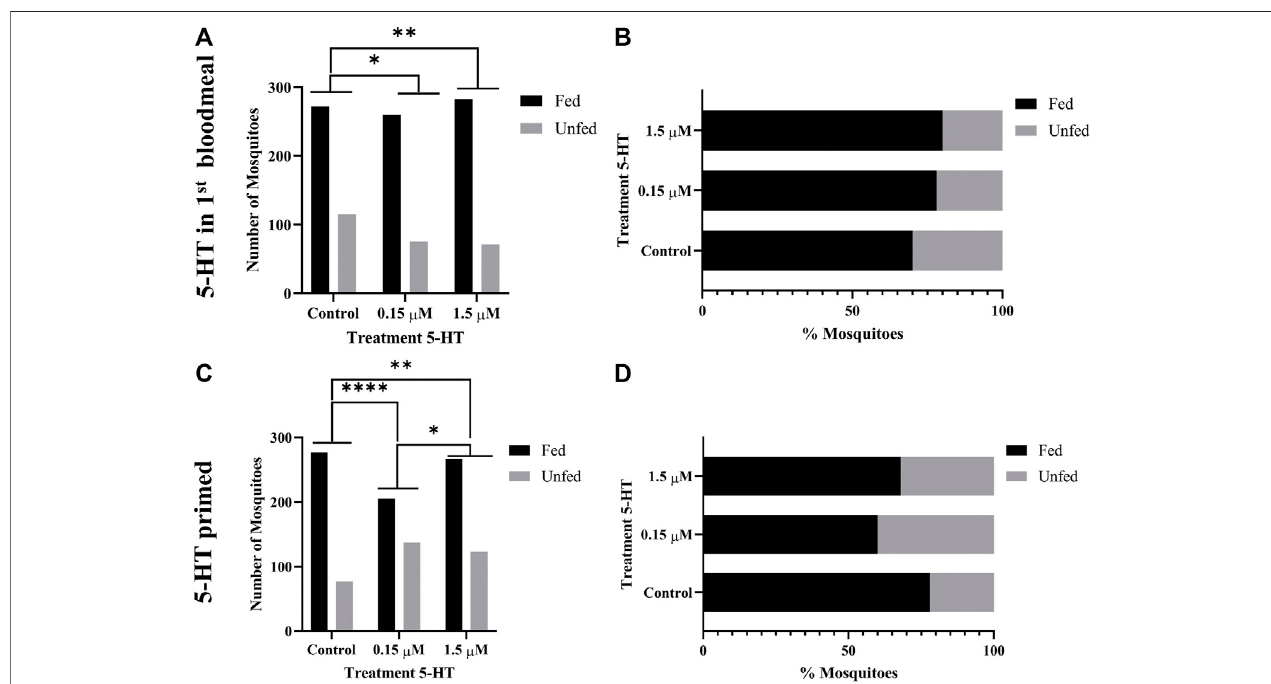
FIGURE 3 | Tendency of uninfected A. stephensi to take a second bloodmeal 4 days later. (A) Numbers of fed and unfed uninfected mosquitoes provisioned with 5-HT in the fi rst bloodmeal and (B) data from (A) shown as percentages of fed and unfed mosquitoes provisioned with 5-HT in the fi rst bloodmeal in each group. N = 5; Fisher ’ sexacttest( α =0.05),*controlvs.0.15 μ M p =0.0277,**controlvs.1.5 μ M p =0.0030. (C) Numbersoffedandunfeduninfectedmosquitoesfollowingprimingfor 3 dayswith5-HT inwaterorwateronlysoaked cottonballsand (D) datafrom (C) shown aspercentagesoffedand unfed 5-HTprimedmosquitoesineach